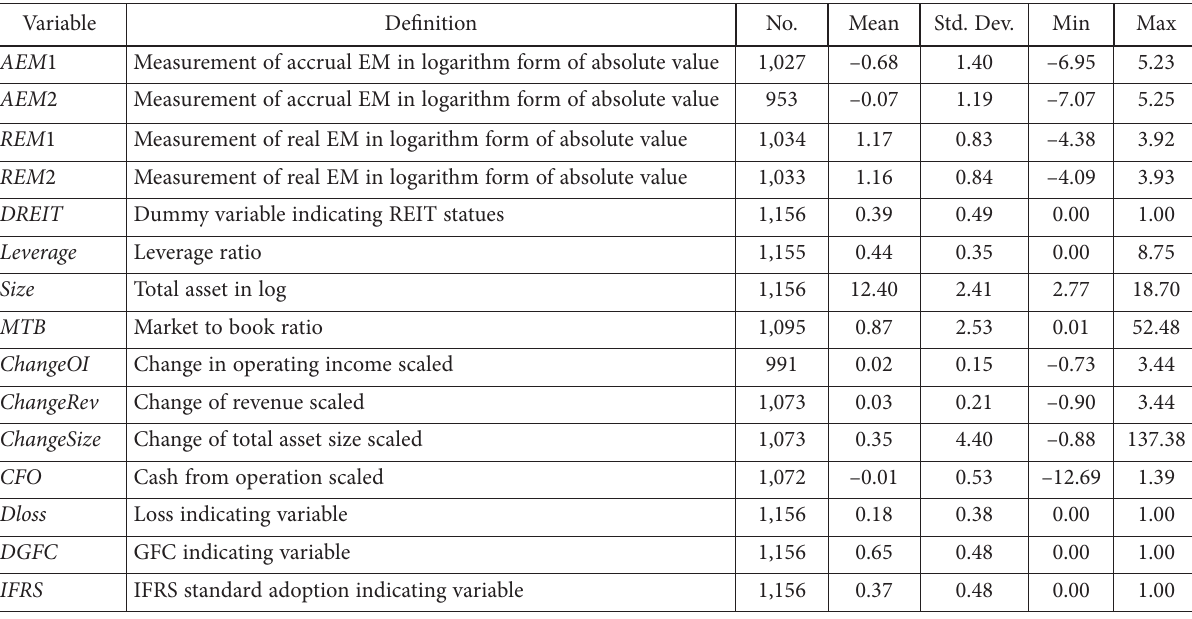
Table 3. Summary of EM measurements and other variables